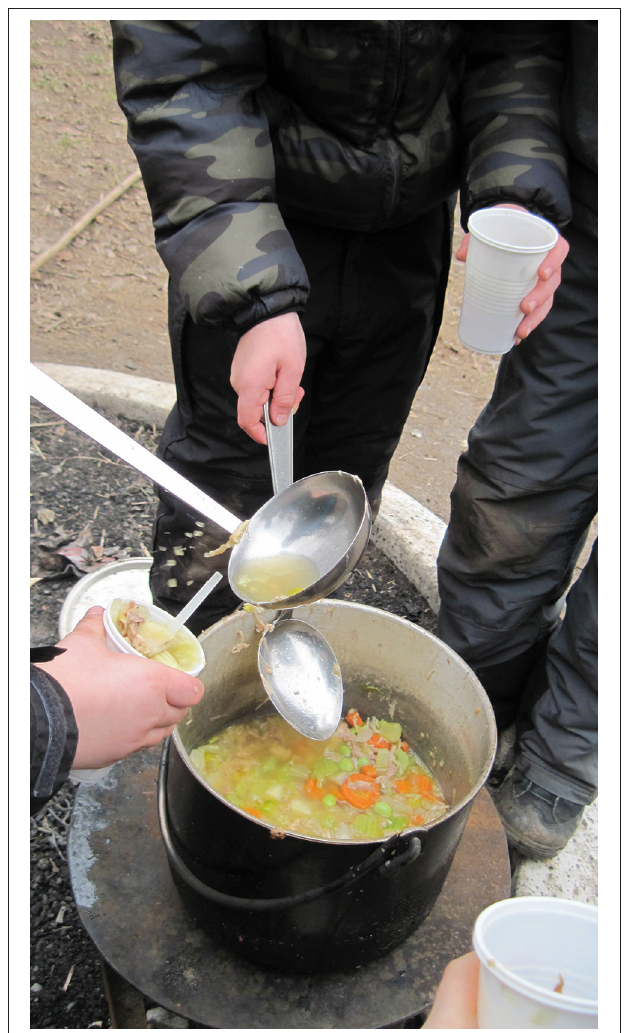
FIGURE 2 | Example from category 3, pupils assesing quantety by sharing the